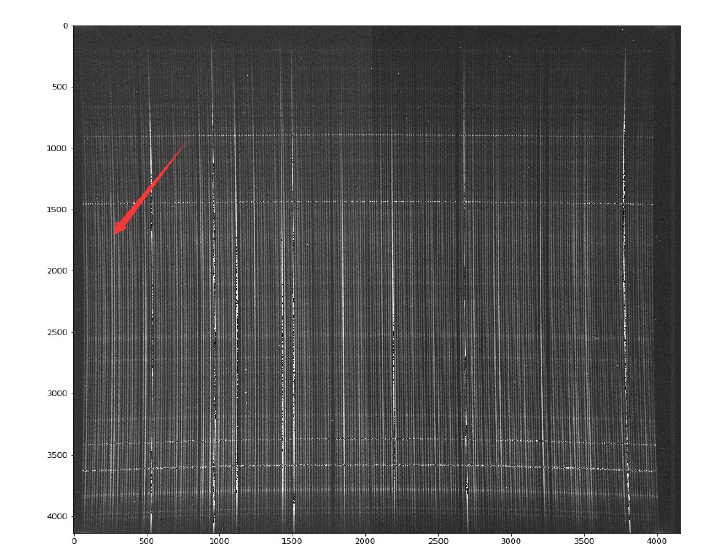
Figure 3. 2D spectra of LAMOST.